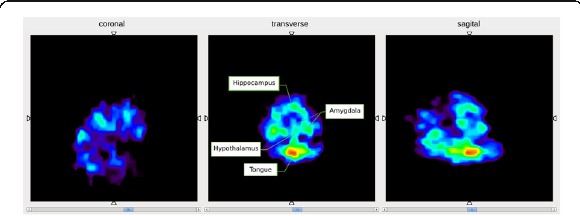
Fig. 1 (abstract A4). Example of a brain image of the 27 g